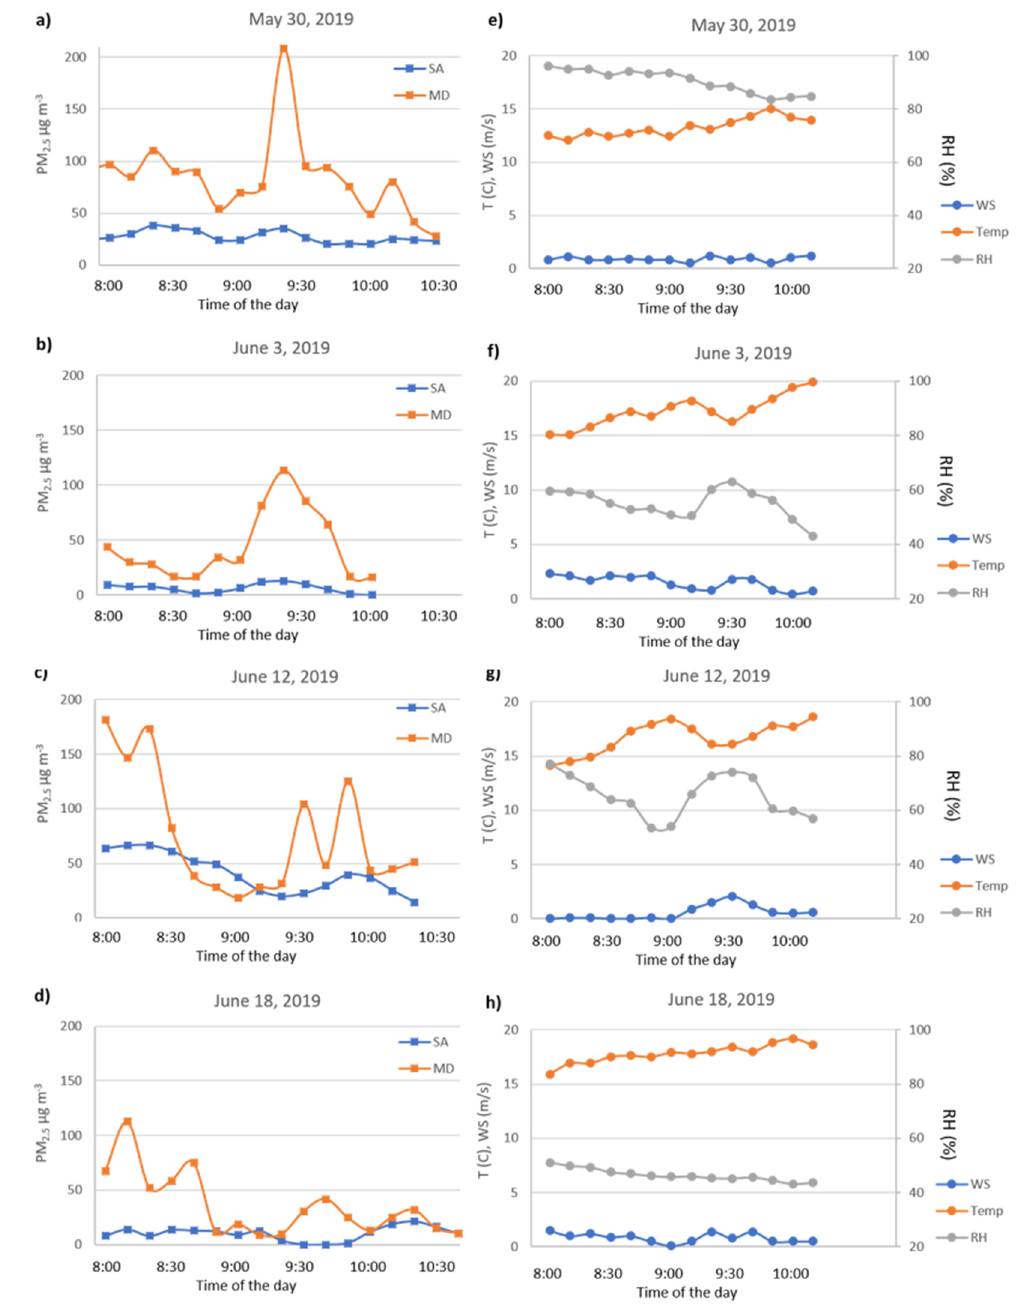
Figure A1. Comparison between PM 2.5 concentrations at a fixed monitoring station (SA) and street-level (MD) for 30 May, 2019, 3, 12, and 18 June, 2019 ( a – d , respectively), and meteorological parameters (wind speed—WS, temperature—Temp and relative humidity—RH) for 30 May, 2019, 3, 12, and 18 June, 2019 ( e – h , respectively), in central Quito, Ecuador during morning rush hour.